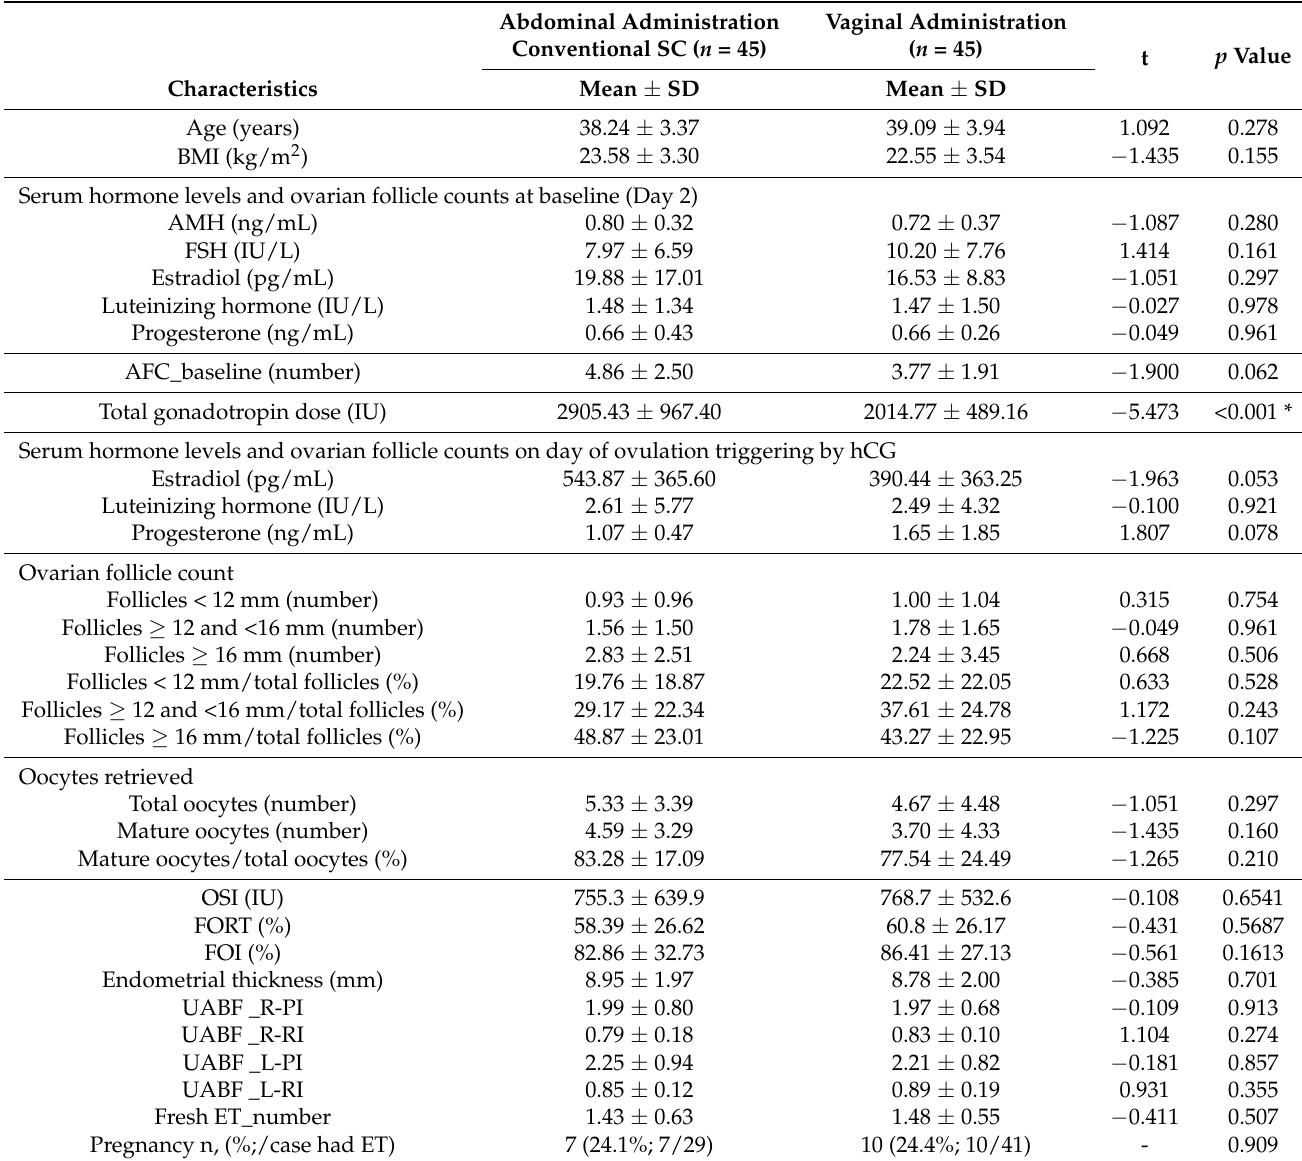
Table 1. Demographic characteristics, serum hormone levels, and follicle counts in subjects who received rhFSH abdominally or